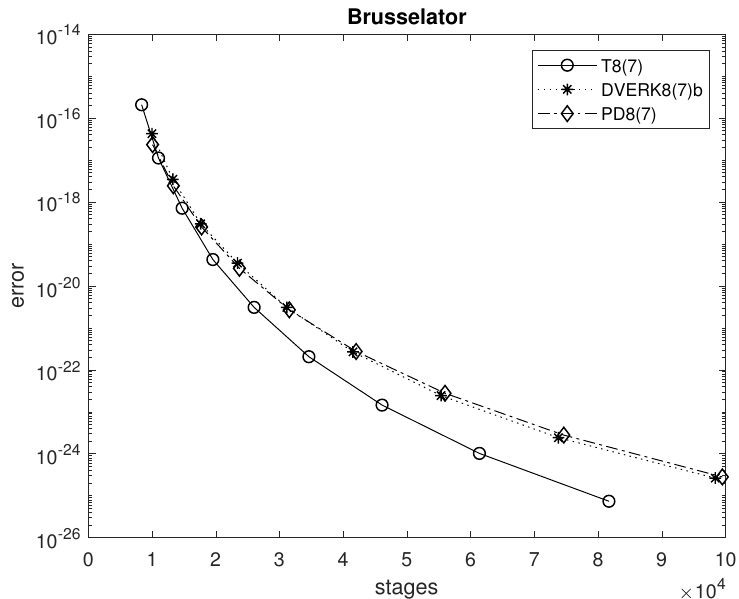
Figure 2. Efficiency plots for the Brusselator.